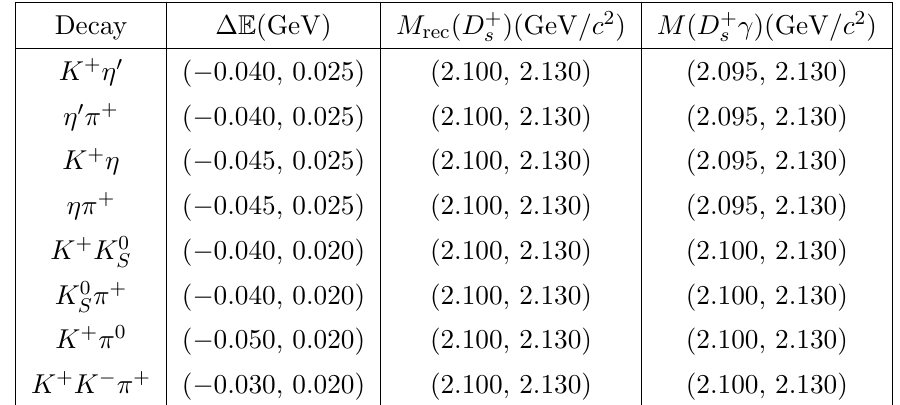
) and M ( D + (cid:13) ) for each D + ! PP 0 decay s s s